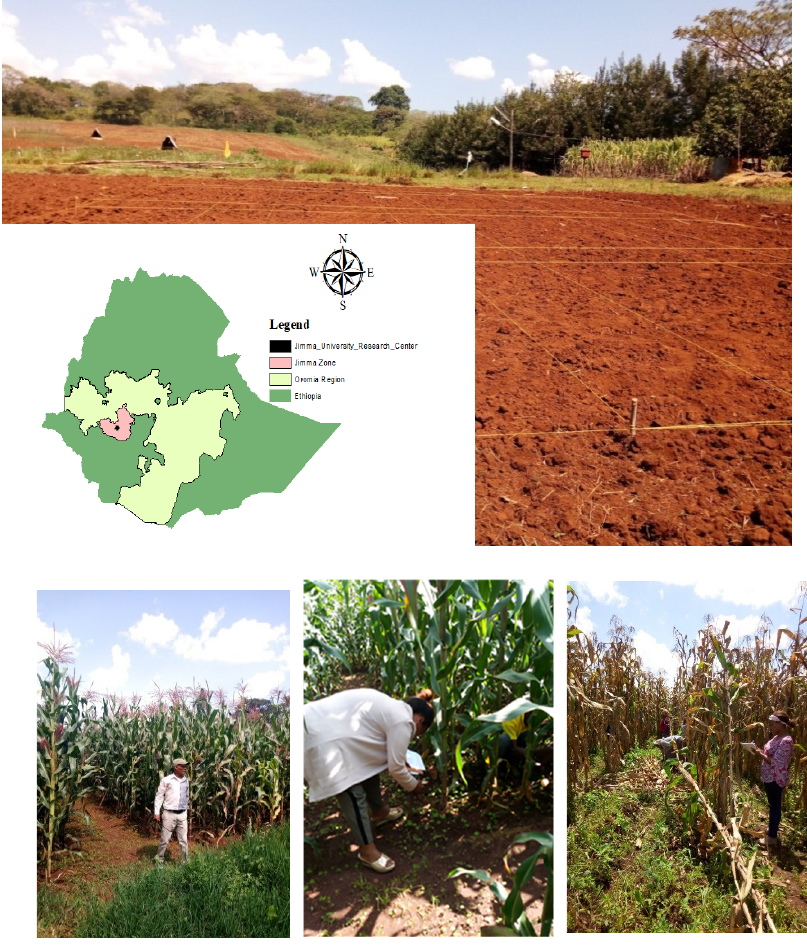
Figure 1. Map of the study site and photos of the field experiment and research activities at the site (Jimma University Research Center, Ethiopia).